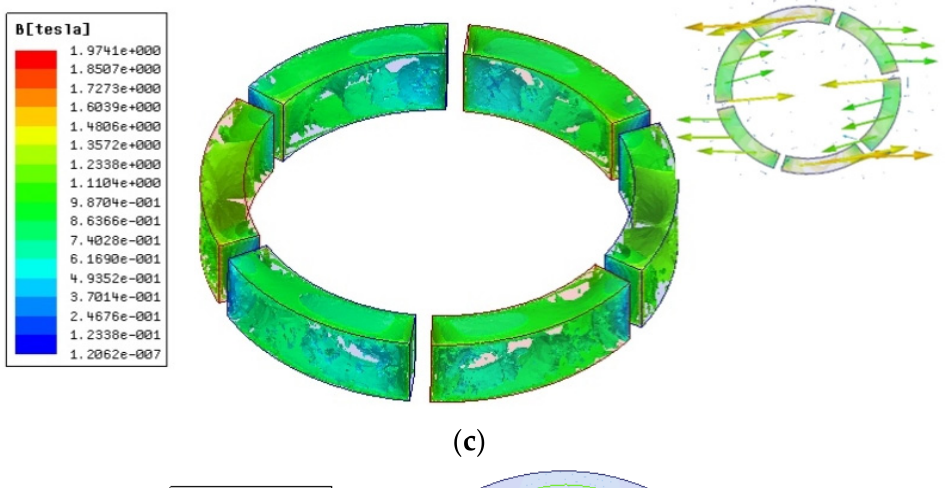
Figure 5. Magnetization modes: ( a ) radial magnetic dense cloud diagram; ( b ) radial magnetic line distribution; ( c ) parallel magnetizing dense cloud diagram; and ( d ) parallel magnetizing force line.